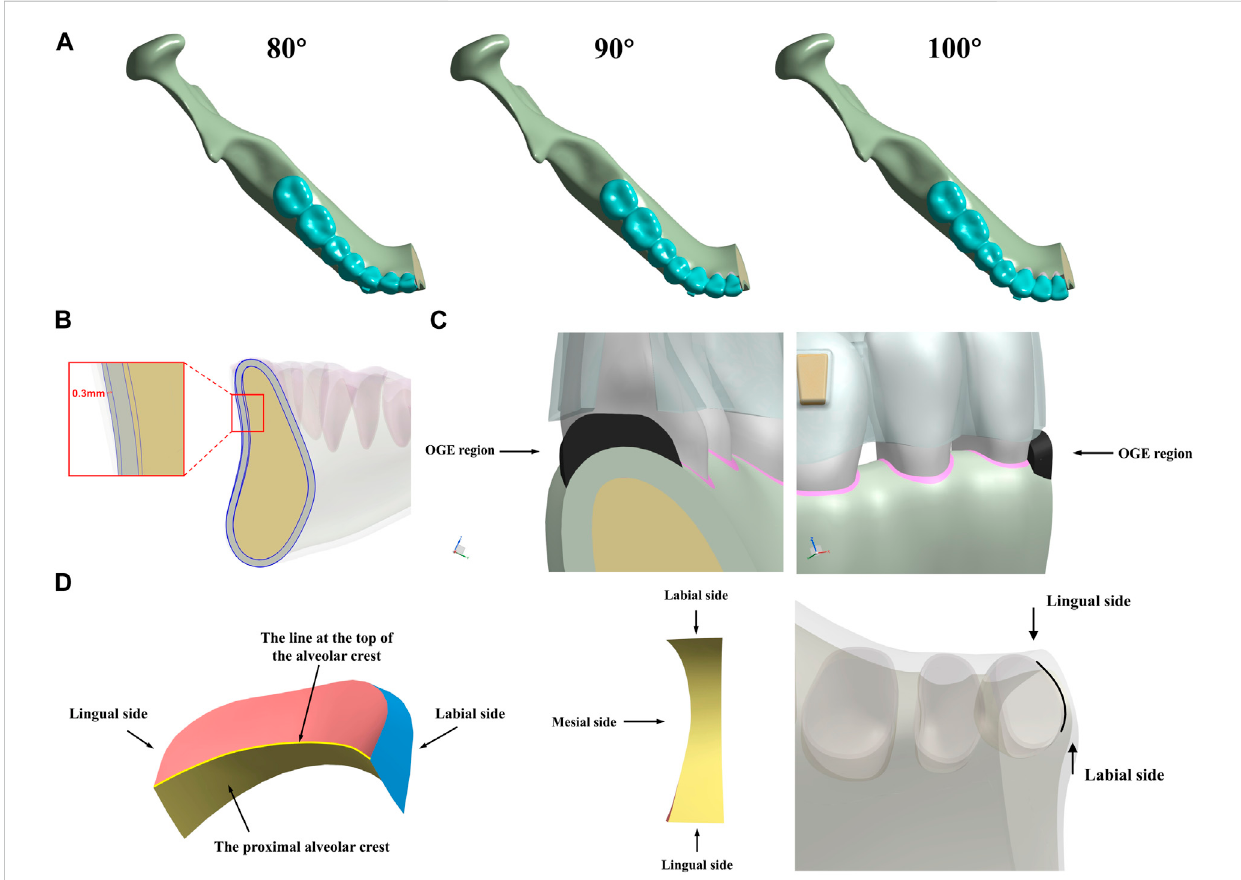
FIGURE 1 Three-dimensional (3D) mandible models for intrusion movement in incisors. (A) different inclinations (80 ° , 90 ° , and 100 ° ), (B) labial bone thickness biotype(thick,thin)and (C) theOGEregion, (D) differentsurfacesinOGEregionandthelineatthetopoftheinterproximalalveolarcrestalongtherootof central incisor.